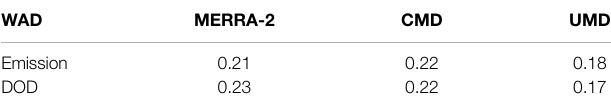
TABLE 1 | Annual averaged dust emission fl ux (unit: 10 − 8 kg/m 2 /s) and DOD based on the MERRA-2 reanalysis and simulated results in the